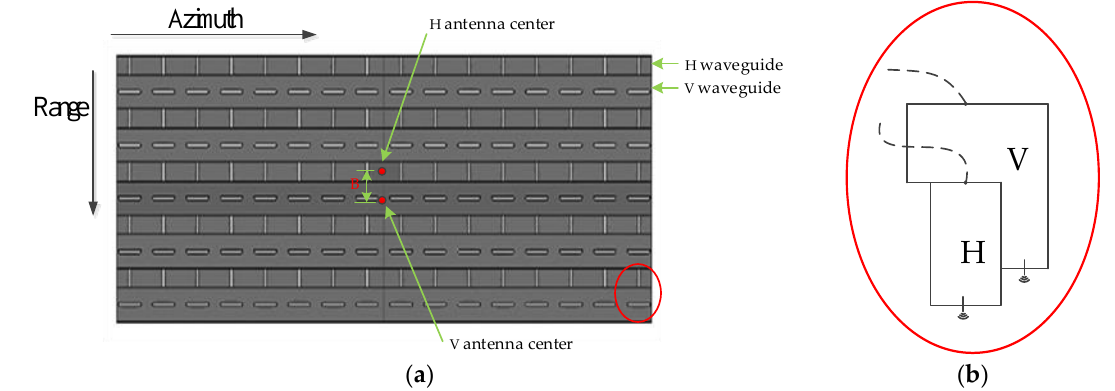
Figure 4. Dual-polarized slotted waveguide antenna: ( a ) Antenna array, ( b ) Structure of H and V waveguide, where ( b ) is an enlargement of the red circle in ( a ).